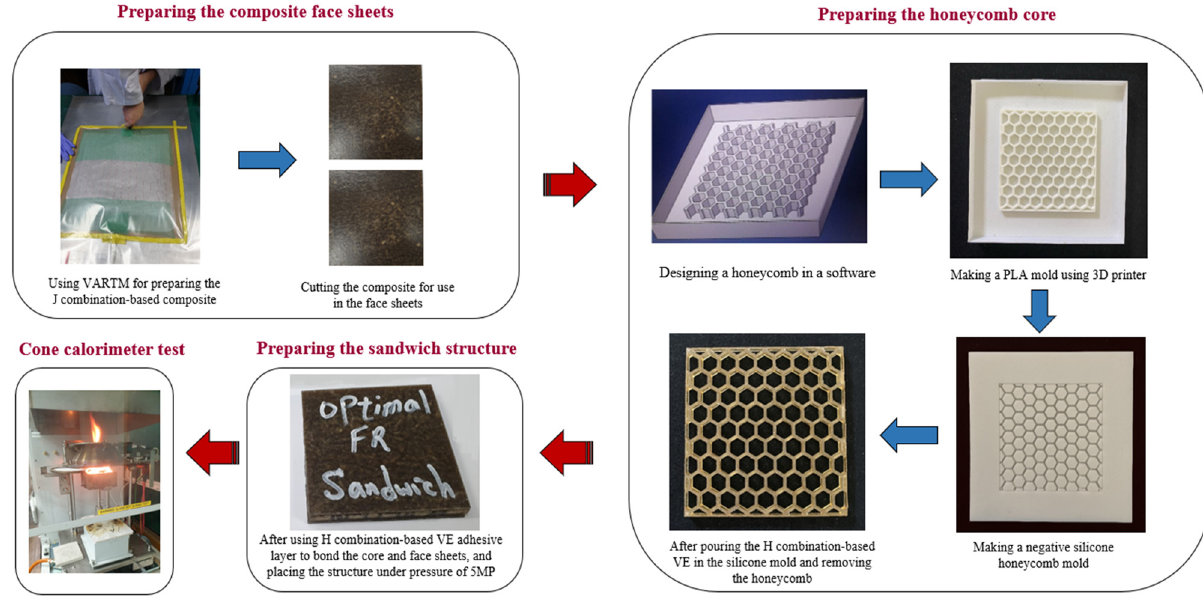
Figure 4: The main steps of preparing the optimal FR sandwich panel for the cone calorimeter test.